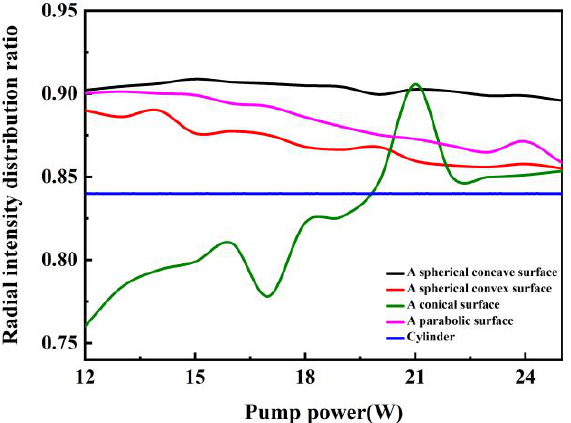
Figure 7. Radial intensity distribution ratio of the laser using five different kinds of saturated absorbers versus pump power.